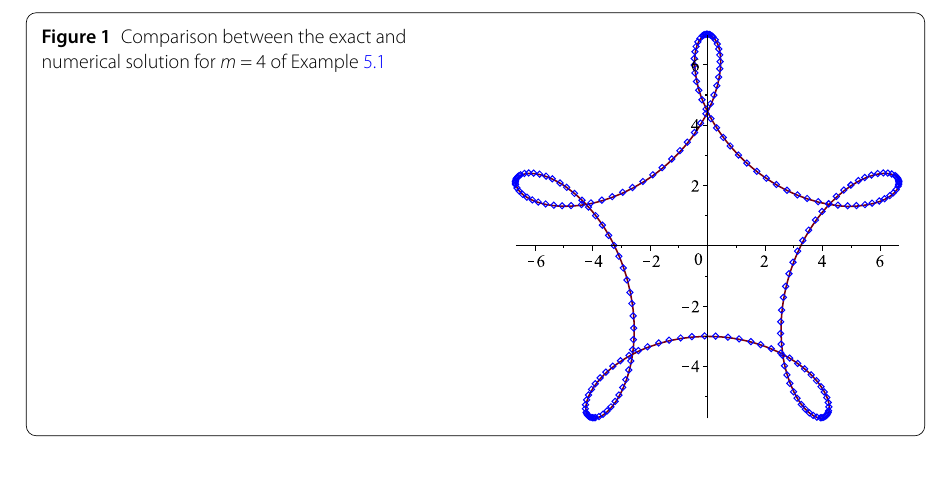
Figure 2 Plot of the absolute errors for m = 4 of Example